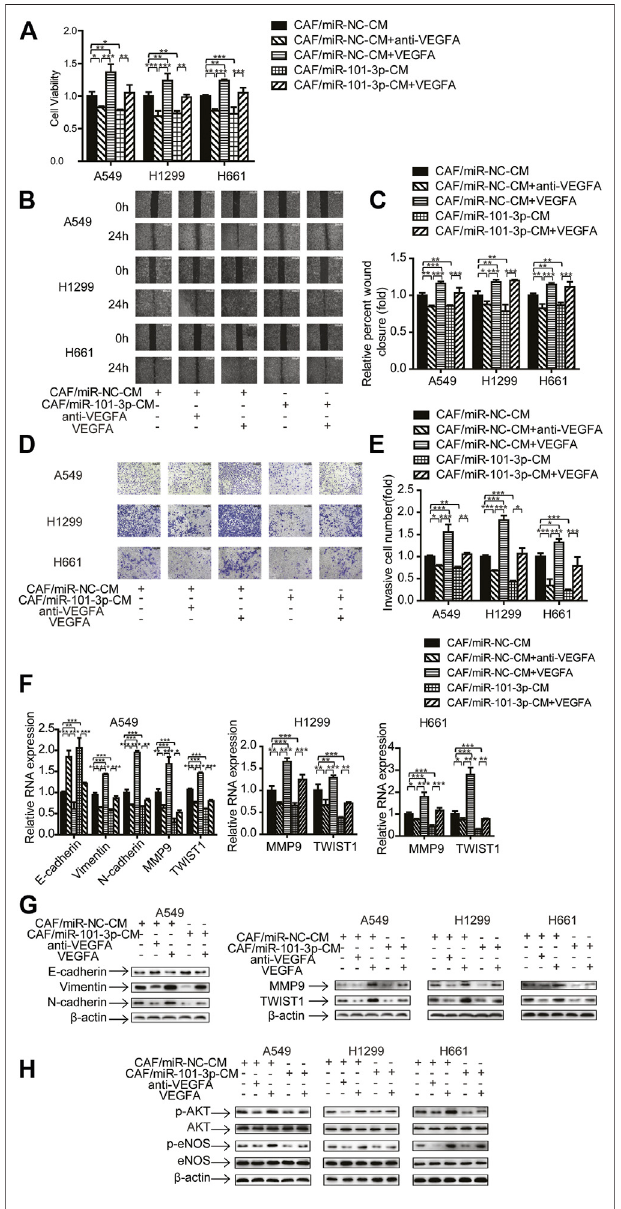
FIGURE6| VEGFAmediatedtheeffectofmiR-101-3p onmigrationand invasion of lung cancer cells Lung cancer cells were cultured in CAF/miR-NC- CM or CAF/miR-101-3p-CM. 20 ng/ml of human recombinant VEGFA or 5 μ g/mlofVEGFAneutralizingantibodywereadded. (A) Cellviabilitywas examined by CCK-8 kit. (B,C) Cell migration was detected by wound healing assay. (D,E) Cell invasion was detected by transwell assay. (F) Gene expression was detected by qPCR. (G,H) Gene expression was detected by Western blots. Values represent the mean ± SD from 3 independent experiments. * p < 0.05; ** p < 0.01; *** p < 0.001.